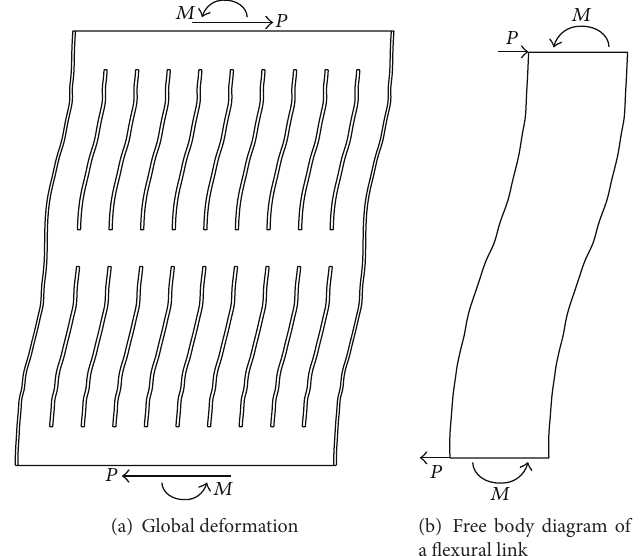
Figure 8: Lateral deformation of the steel slit wall subjected to horizontal loads.